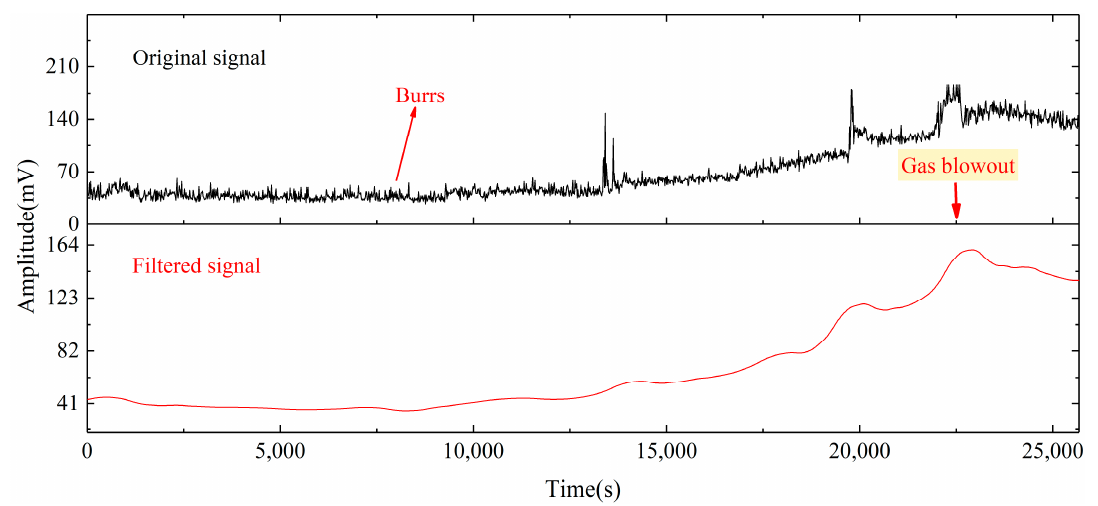
Figure 10. Decomposition result of the two dangerous signals. ( a ) AE signal. ( b ) EMR signal.